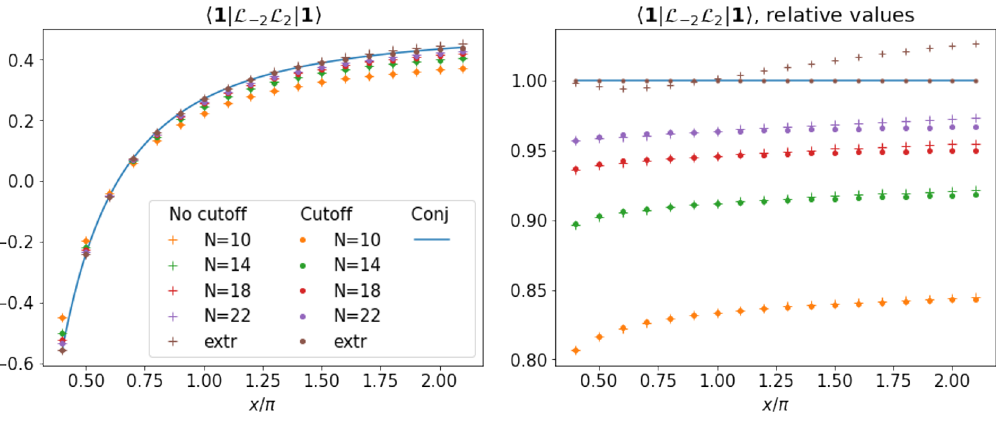
Figure 2 . Finite-size estimates for the central charge c , obtained from (6.8) for various N , plotted against x . The left panel shows the actual estimates for c , and the right panel their ratio with (cid:25) respect to the CFT result (\Conj"). We display the results for N = 10 ; 14 ; : : : ; 22 obtained by two methods, \No cuto(cid:11)" and \Cuto(cid:11)", as explained in the main text. Also shown are extrapolations \extr" of the two data sets, obtained from a 7th-order polynomial (cid:12)t to an extended set of sizes N = 8 ; 10 ; : : : ;